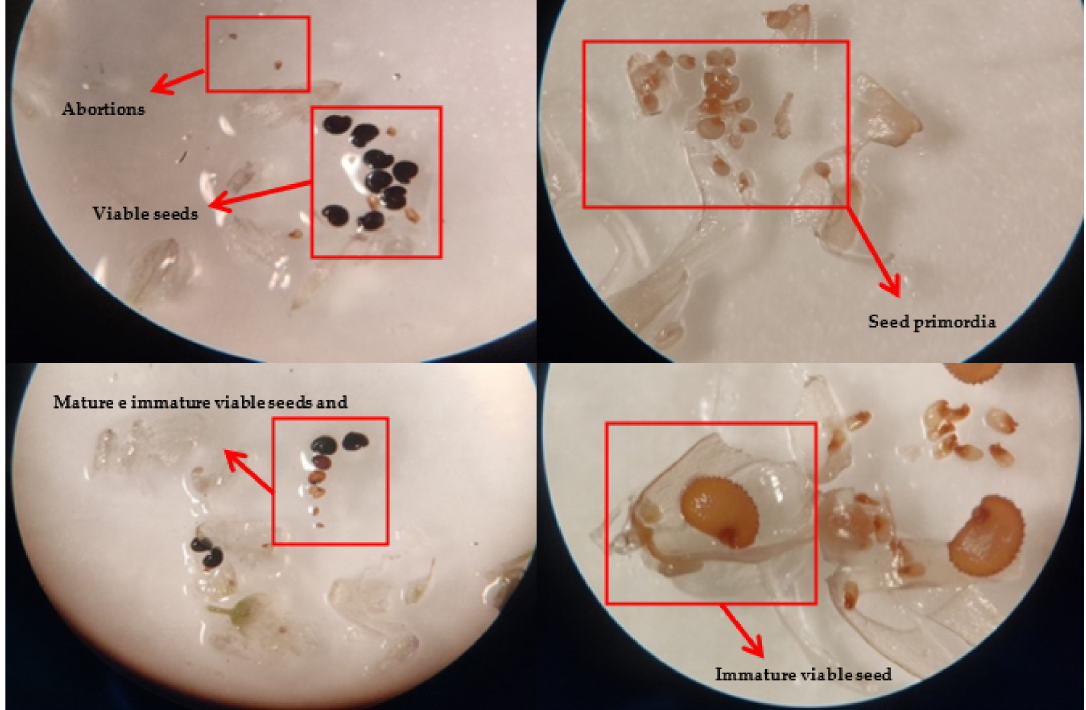
Figure 7. Images of the dissection process of flowers and fruits during the study of seed primordia and mature